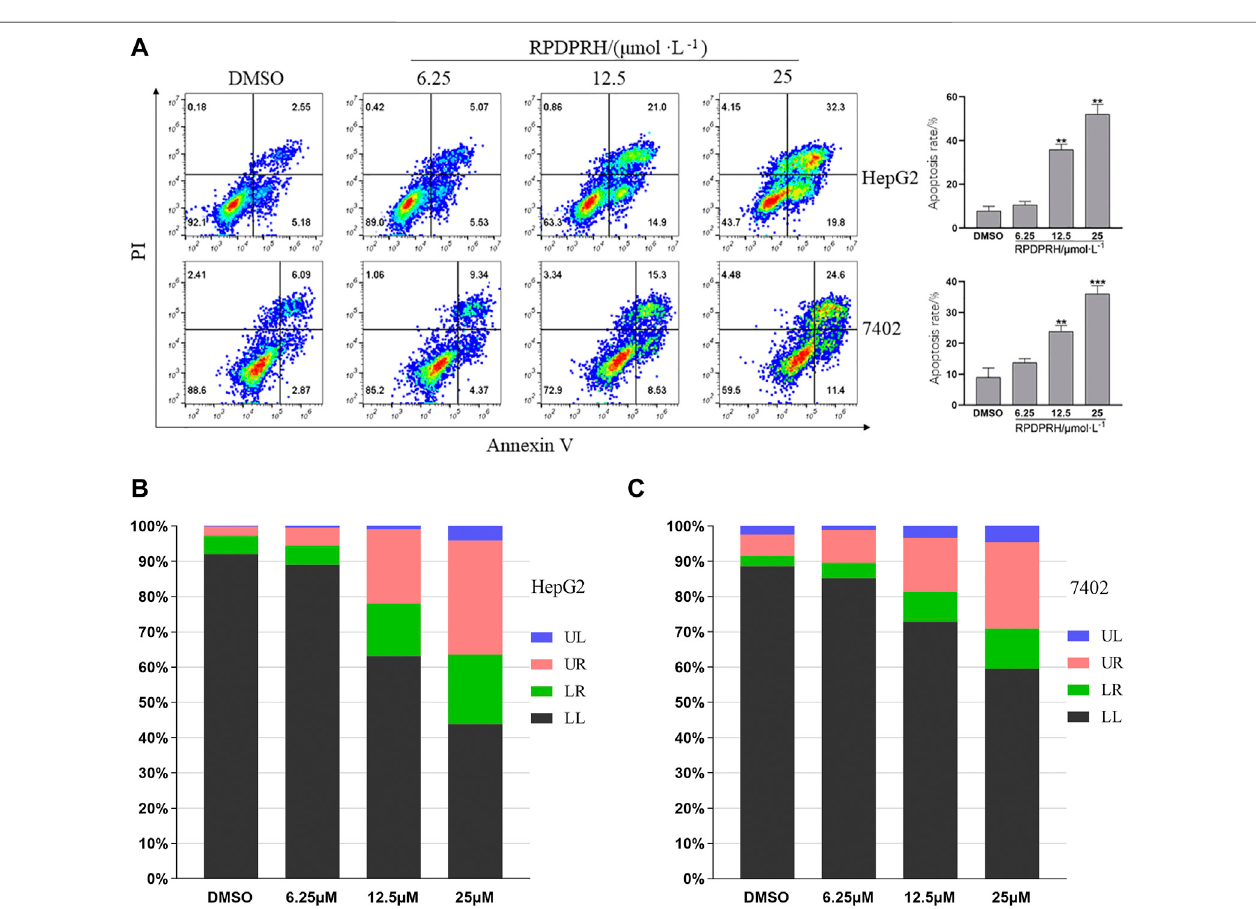
FIGURE1| EffectofRPDPRHontheapoptosisofHepG2 and7402cells.Note: (A) :Flowcytometryanalysesofapoptosisinduction inHepG2and7402cellsafter beingtreatedbyRPDPRHfor48 handthetotalapoptosisrate.ComparedwiththeDMSOcontrolgroup,** p < 0.01and*** p < 0.001,( ‾ x±s,n=3). (B) and (C) :Livingcell (LL), early apoptotic cell (LR), late apoptotic (UR), and necrotic cell/fragment (UL) rate of HepG2 and 7402 cells were analyzed.